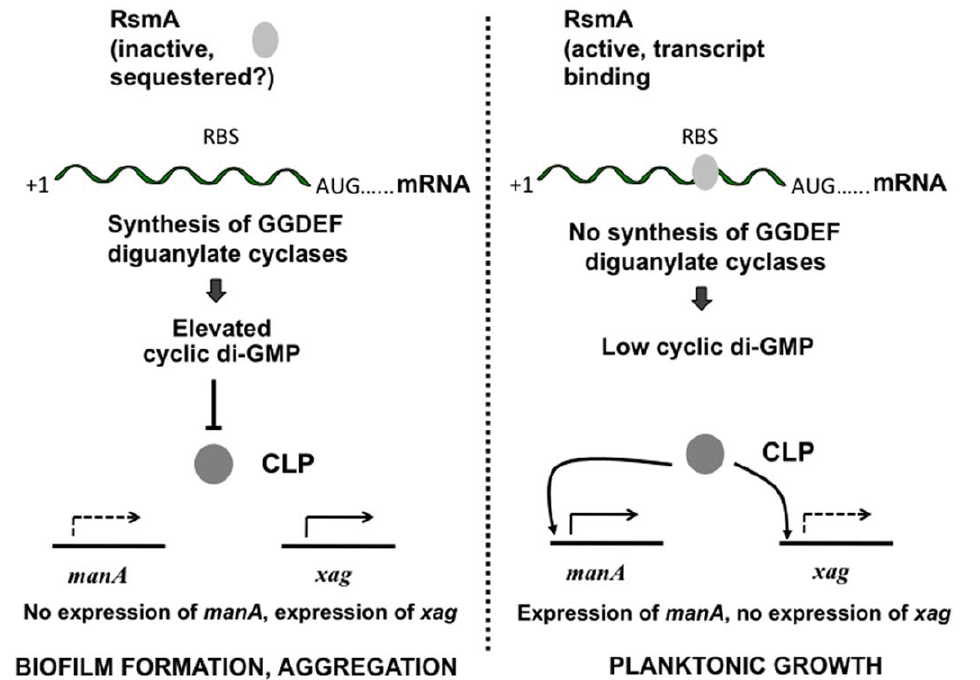
Figure 9. Model of regulation of biofilm formation and aggregation in Xcc by RsmA. The post-transcriptional regulator RsmA influences the expression of three genes encoding GGDEF domain proteins ( XC_1803, XC_2715 and XC_2866 ) by binding to the transcripts. RsmA binding inhibits translation of these mRNAs. Inactivation of RsmA, perhaps by sequestration by small RNA species, allows translation to occur, leading to elevated cellular levels of cyclic di-GMP. The binding of cyclic di-GMP to the transcription factor Clp prevents DNA binding. This reduces expression of manA , which requires Clp for expression but activates expression of the xag genes for which Clp is a repressor. Since ManA promotes biofilm dispersal and the xag gene products promote biofilm formation, these effects contribute to enhanced biofilm formation and aggregation. Conversely, when RsmA binds to the transcripts of XC_1803, XC_2715 and XC_2866, the cellular levels of cyclic di-GMP are lower, manA expression is favoured and xag gene expression is reduced. This leads to biofilm dispersal and planktonic growth. We do not exclude the possibility that RsmA has additional direct or indirect effects on manA or xag gene expression or that regulation by Clp is more indirect, for example by positive regulation of a distinct repressor protein or that other functions regulated by cyclic di-GMP also have a